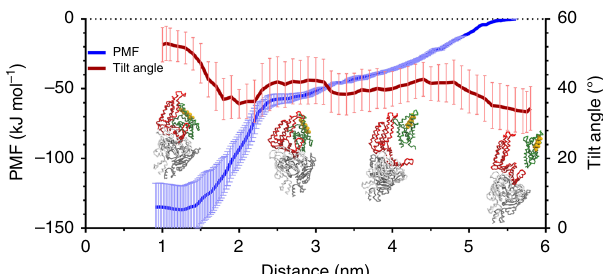
Fig. 4 Dissociation of S-component from ECF complex. Potential of mean force of ECF module and S-component association (blue). Error bars were computed with bootstrapping. Average tilt angle between helix 5 and the positive z -direction of the simulation box along the dissociation pathway (red). Error bars are standard deviations. Representative snapshots of ECF and S-component along the dissociation pathway are shown. Toppled state is on the left and canonical state is on the right. Color coding is the same as Fig. 1. Helix 5 is highlighted in yellow. Source data are provided as a Source Data fi